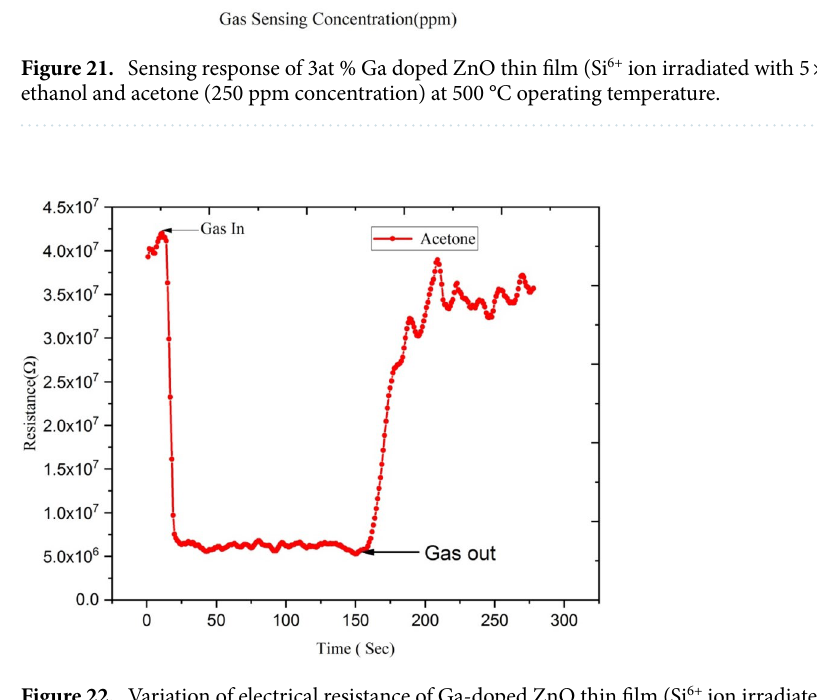
Figure 22. Variation of electrical resistance of Ga-doped ZnO thin film (Si 6+ ion irradiated at 5 × 10 13 ion fluence) with time for 250 ppm concentration of acetone